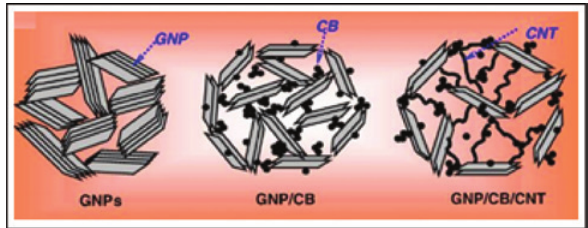
Figure 1: Schematic illustrations of the synergistic effects among the GNPs, CB and CNTs [18].